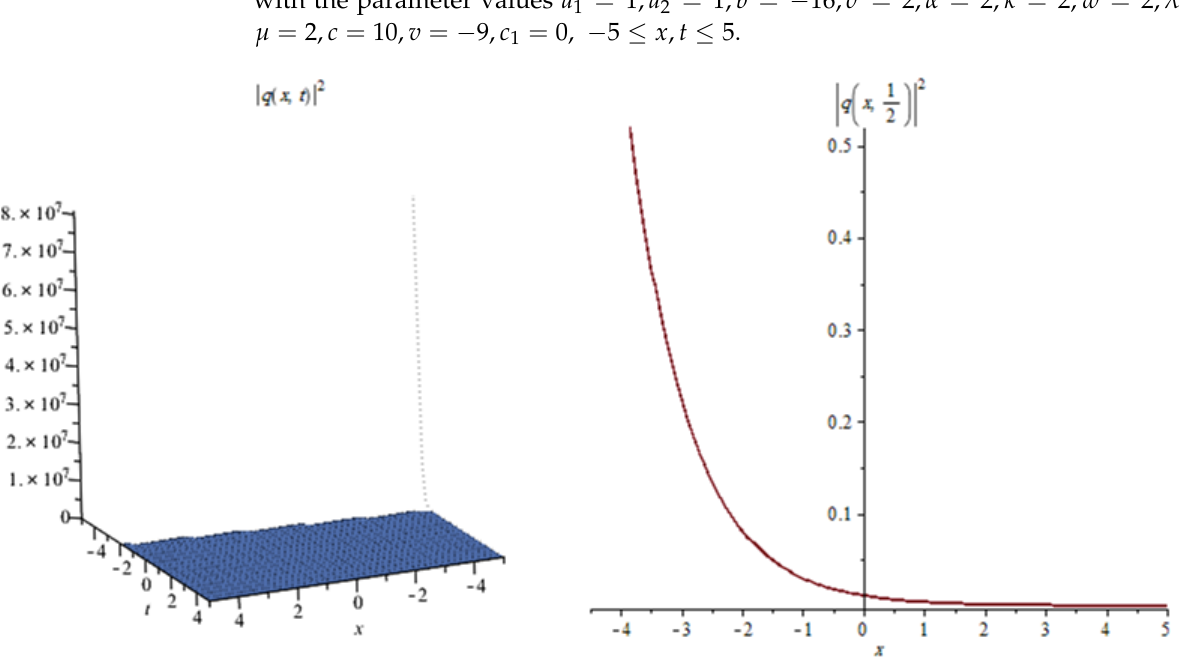
16, σ = 2, α = 2, κ = 2, w = 2, λ = 2, −